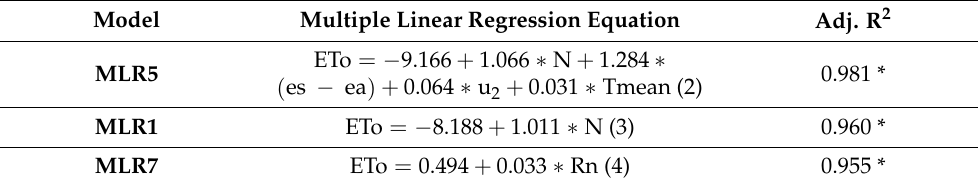
Table 3. Formulae of the MLR model with the best performance (MLR5) and the two most accurate models with one input (MLR1,